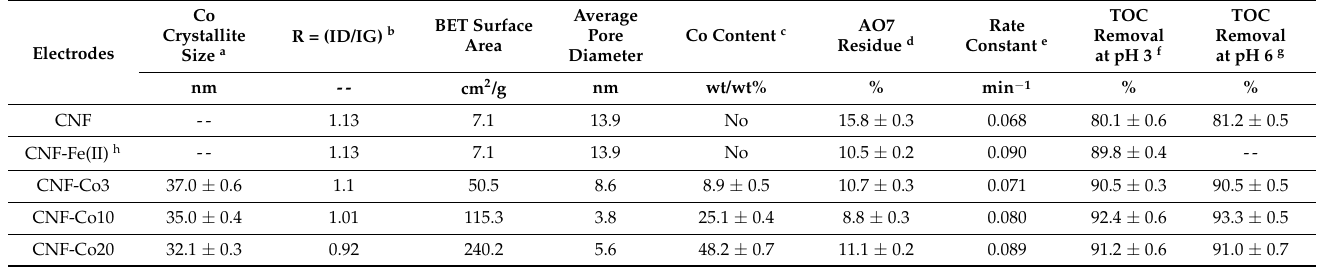
Table 1. Characteristics of the tested cathode materials and their corresponding AO7 decolorization rate and TOC removal percentage at different